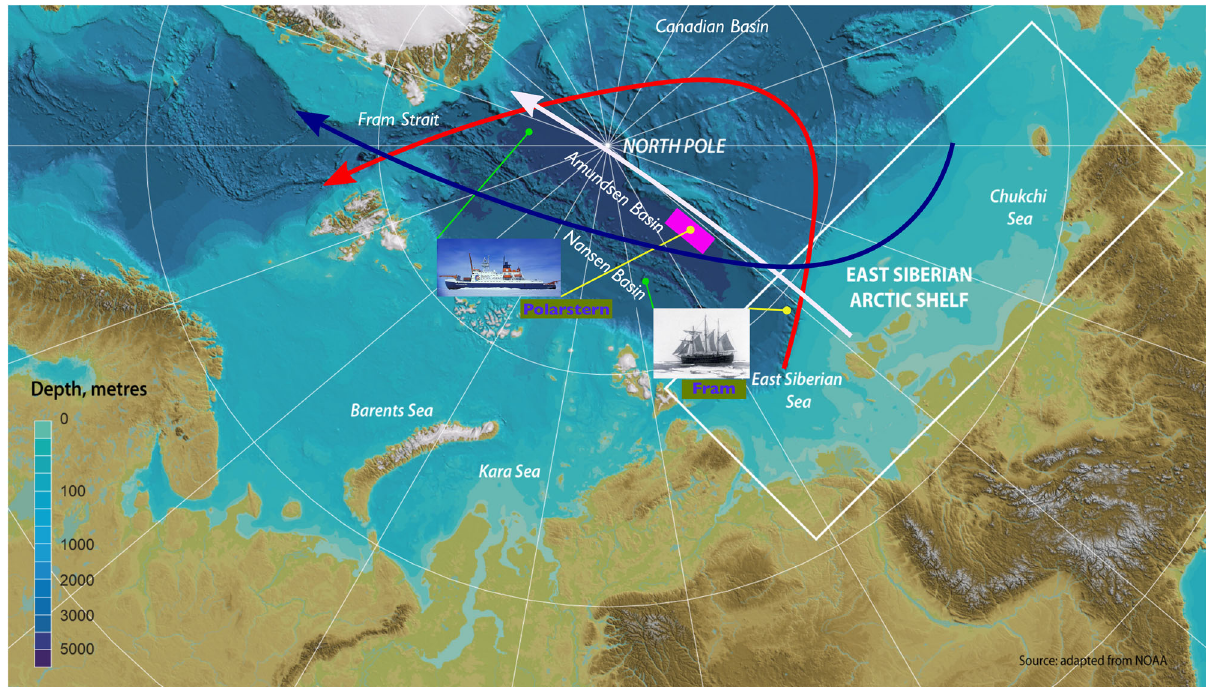
Fig. 1 Canonical view of the Arctic Transpolar Drift. Schematic of the envelope of variability of the Transpolar Drift (TPD) and areas of the major Arctic expeditions, relevant to this study. The climatological path of the TPD from the East Siberian Arctic Shelf towards Greenland/Fram Strait (white arrow) is aligned with the sea fl oor topography of the Lomonosov Ridge. The particle release patch for this study (magenta box) encloses the start location of the Polarstern, the central observatory of the MOSAiC expedition. The start and endpoints of the drift of the Polarstern and the Fram are shown by yellow and green circles, respectively. The variation of the TPD associated with positive/negative phases of the decadal variability of the Arctic Oscillation/vorticity index are shown by red/blue arrows, respectively. Figure adapted from a version provided by GRID-Arendal (See Acknowledgments), with drift arrows inspired by Mysak 7